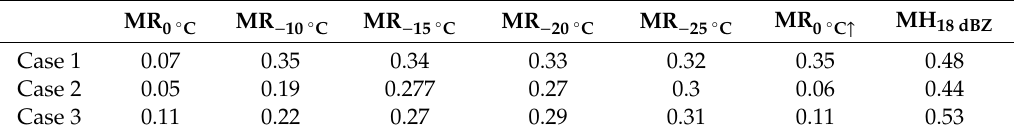
Table 3. The Correlation between lightning and radar echo intensity at di ff erent temperature levels in the Case 1, Case 2, and Case 3 (MR 0 ◦ C , MR − 15 ◦ C , MR − 20 ◦ C , MR − 25 ◦ C , and MR 0 ◦ C ↑ are the Maximum echo intensities at temperature layers of 0 ◦ C, − 15 ◦ C, − 20 ◦ C, − 25 ◦ C, and above 0 ◦ C, respectively; H18DBZ is the maximum height of 18